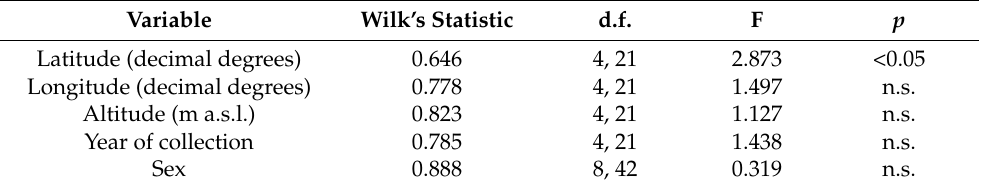
Table 3. Results of general linear model multivariate analysis of variance (GLM MANOVA) on the first five Principal Components obtained from a PCA done on cranial measurements of Rhinolophus hipposideros from Italian populations (n = 31) collected between 1869–2002. Sex (a categorical variable) was entered as the main factor, all other (continuous) variables as covariates. Data that did not meet test assumption were log-transformed for